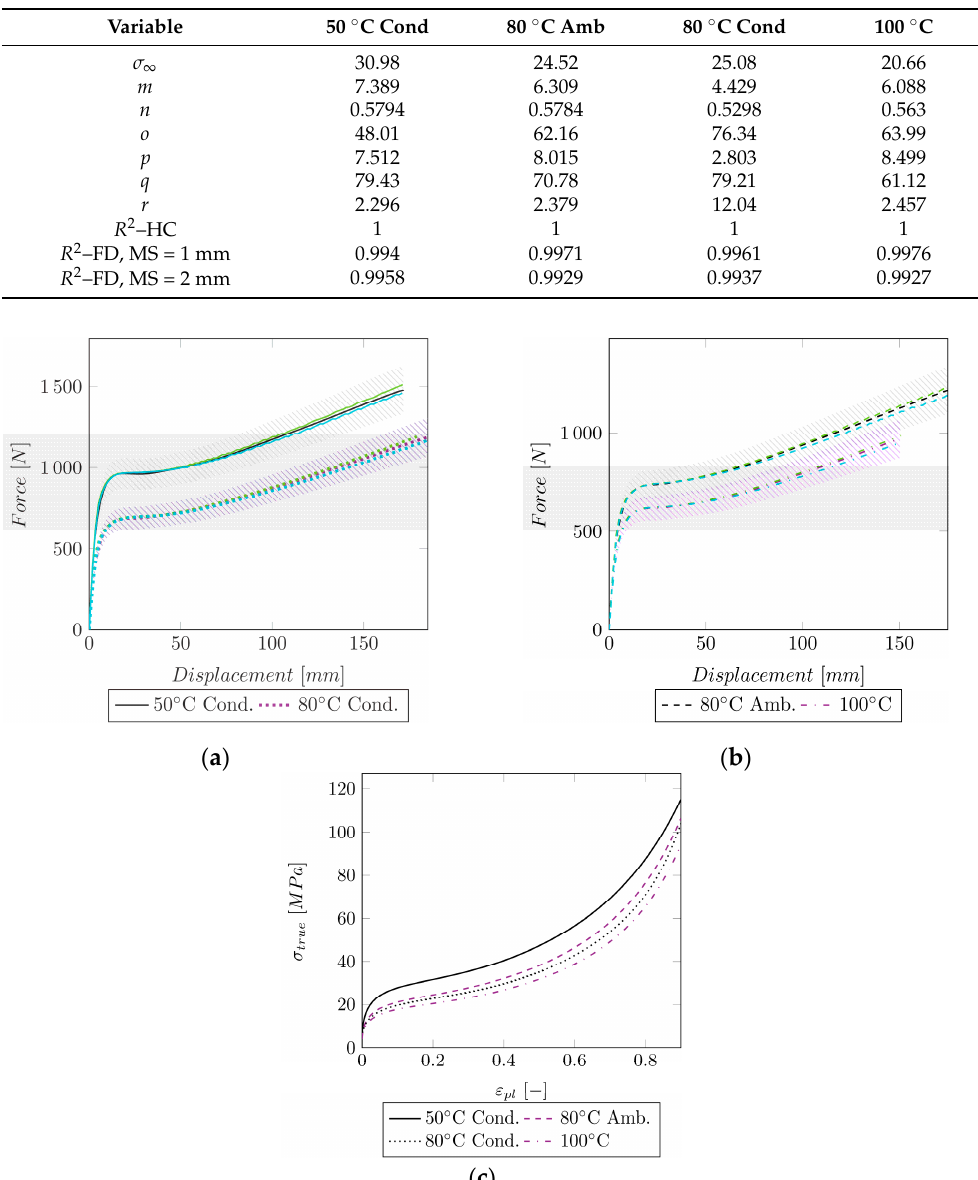
Table 4. Variables of the extended Hockett–Sherby model for Group III (50 ◦ C Cond, 80 ◦ C Amb/Cond, and 100 ◦ C). R 2 –HC is the goodness of the extended Hockett–Sherby model to the experimental HC. R 2 –FD, MS = 1 mm is the goodness of the resulting force–displacement curve using a mesh size of 1 mm; and R 2 –FD, MS = 2 mm is the quality of the resulting force–displacement curve using a mesh size of 2 mm.